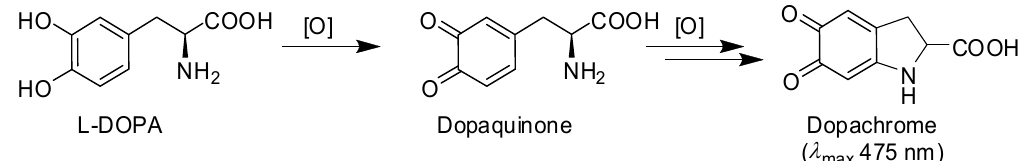
Scheme 1. Dopachrome formation by tyrosinase-catalyzed oxidation of 3,4-dihydroxy- L -phenylalanine ( L -DOPA). λ max : Wavelength of maximum absorbance.